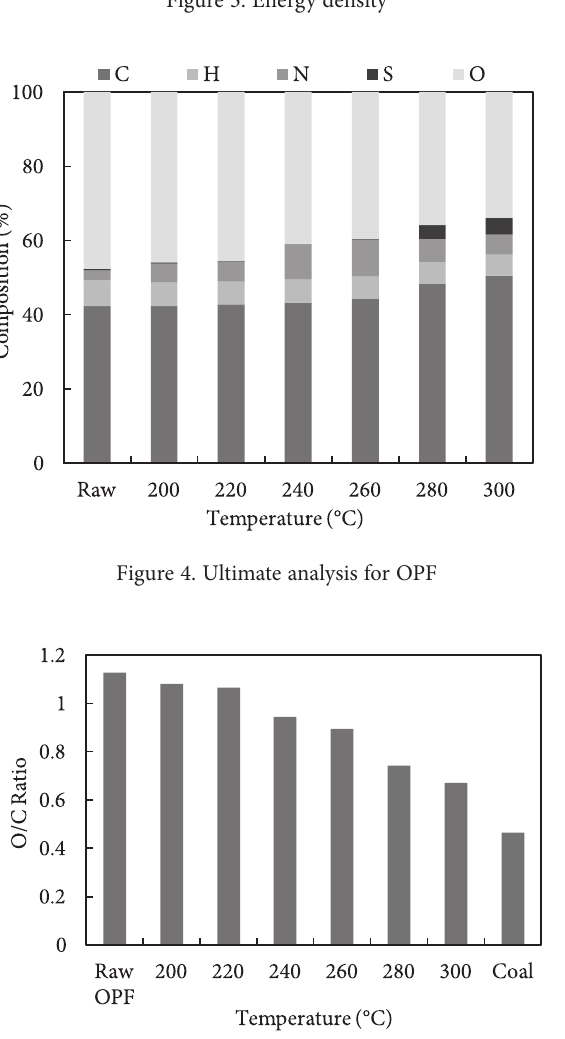
Figure 3. Energy density